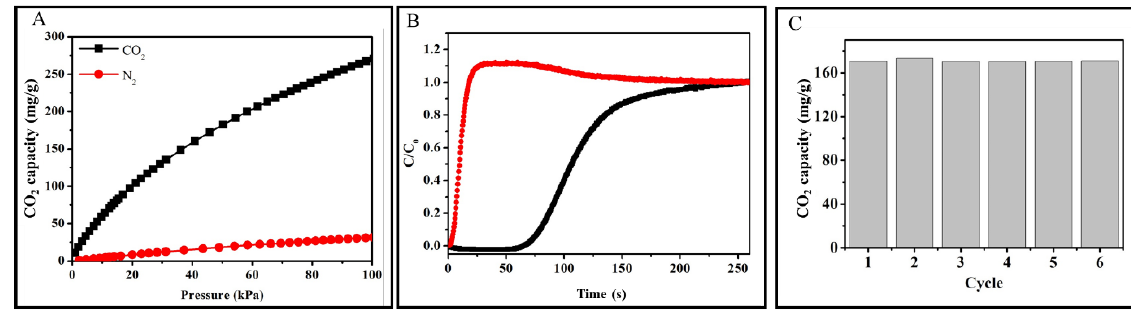
Figure 10. CO 2 and N 2 adsorption isothermals of ACRF-40C-85%-800 at 273 K ( A ); breakthrough curves of CO 2 /N 2 of ACRF-40C-85-800 at 298 K ( B ); CO 2 capacity at 298 K of ACRF-40C-85%-800 for six cycles ( C ).